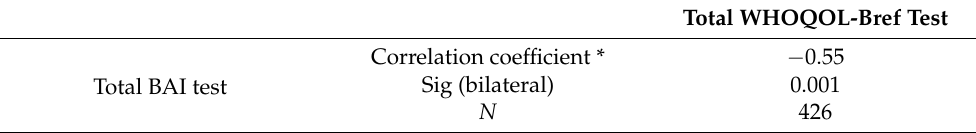
Table 3. WHOQOL-BREF and BAI test